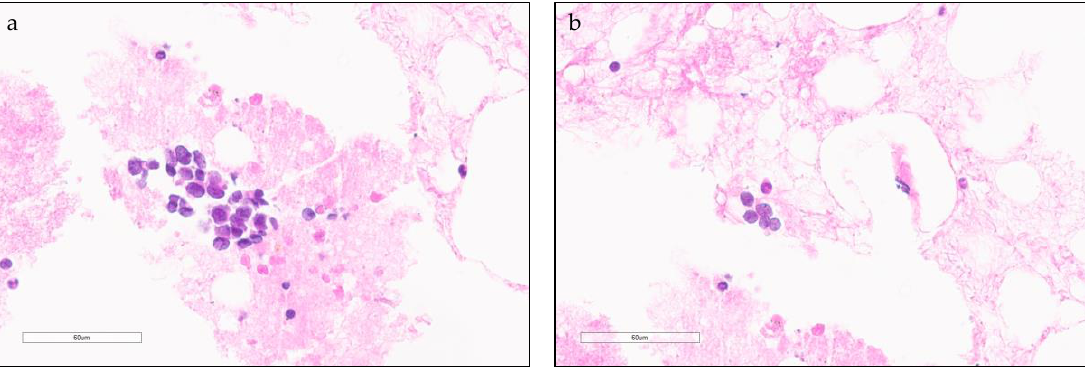
Figure 1. Small cell lung carcinoma (SCLC) cytological and histological characteristics. ( a , b ) High power field view of SCLC in cellular aspirates. Loosely arranged small blue cells with scant cytoplasm and fine chromatin features (arrow).